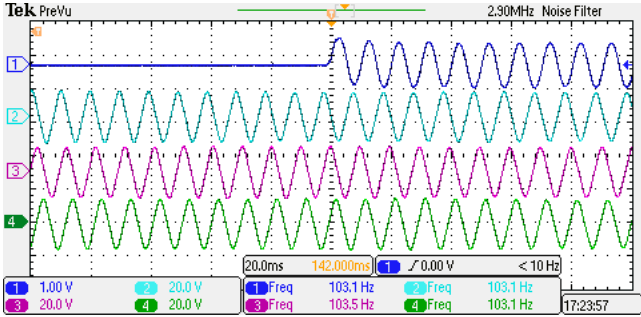
Figure 9. Measured short ‐ circuit phase current (trace 1) and its adjacent phase back ‐ EMFs (traces 2– 4) (10 ms/div, 10 A/div, 20 V/div).